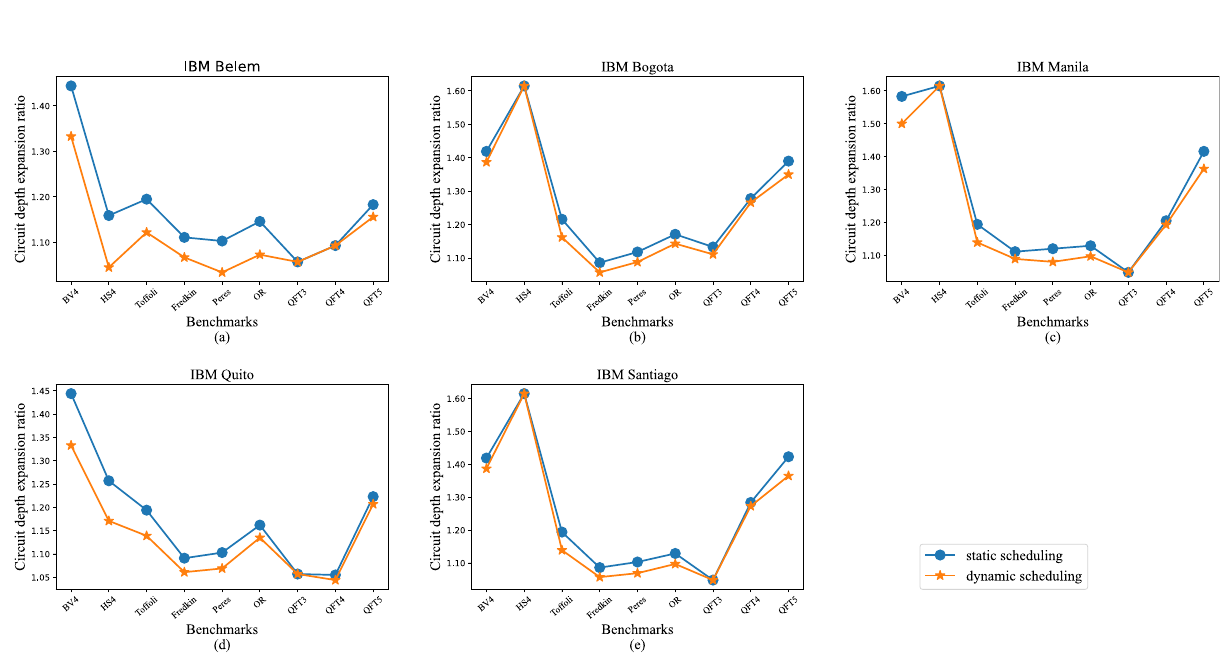
Figure 3. Circuit depth expansion based on various IBM quantum computers. The baseline is the circuit depth using a traditional one-to-one control system. The orange line with star marker shows the expansion ratio using our self-defined static scheduling method and the blue line with circle marker shows the results using our dynamic scheduling method inspired by scoreboard algorithm in classical